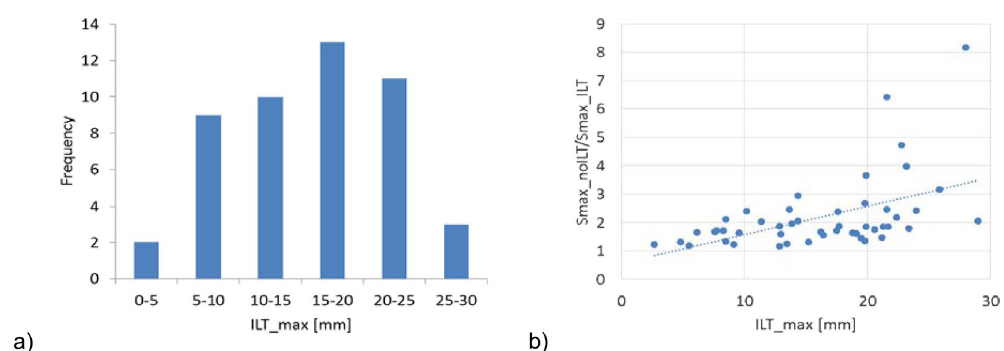
Figure 6. Influence of ILT thickness. ( a ) The distribution of maximum ILT thickness for the analysed cases. ( b ) Influence of maximum ILT thickness on the ratio between the maximum principal stresses computed in the “No ILT” and “ILT pressure” modelling